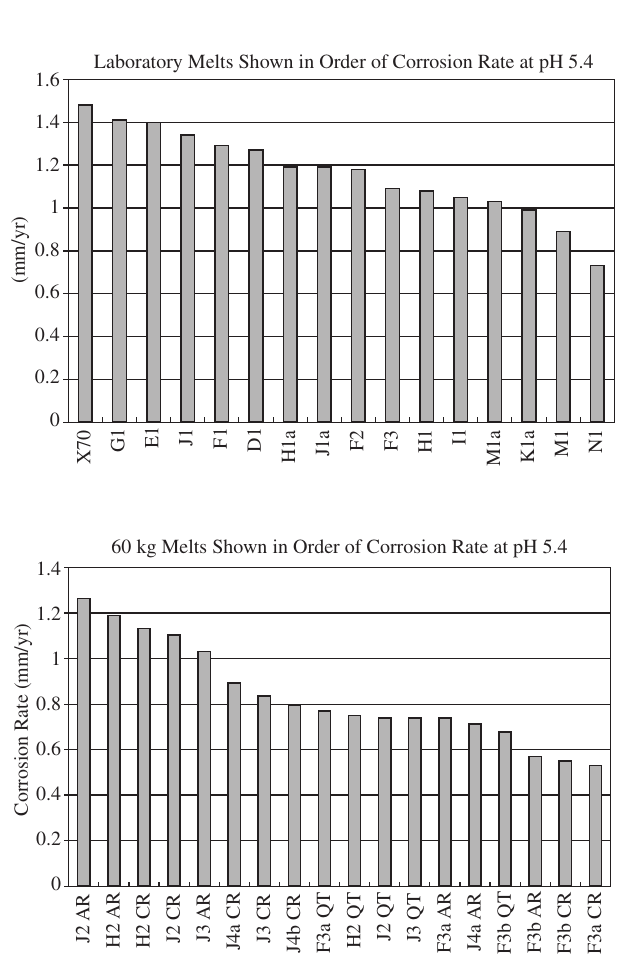
Figure 4. Laboratory sorting corrosion tests showing corrosion rate for a range of steels from the 25 g laboratory melts and 60 kg melts, illustrating the effect of alloying coupled with the processing route (AR = As-rolled; CR = Controlled-rolled; QT = Quenched and tempered).